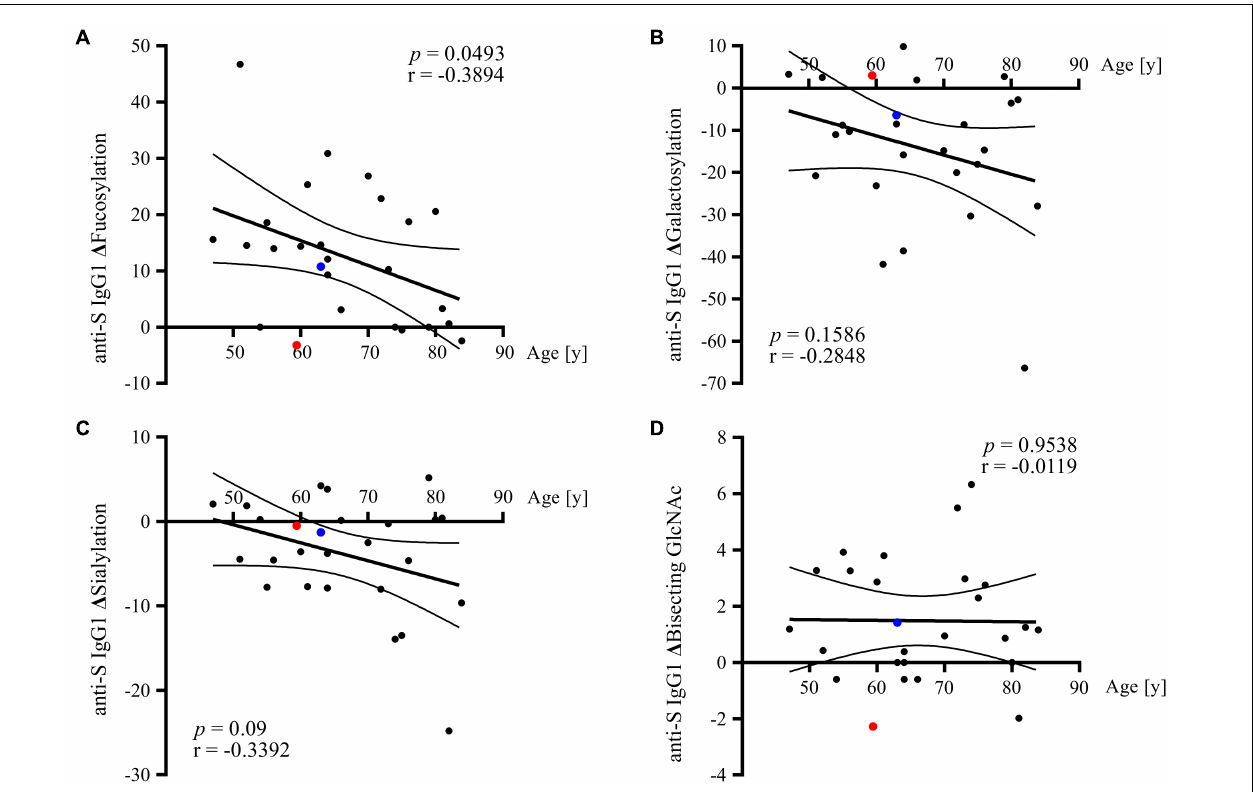
FIGURE 5 | Correlation of anti-S IgG 1 glycosylation alterations with patients’ age. In each graph, the Y axis represents the difference ( (cid:49) ) in the relative abundance of the respective glycosylation trait recorded between the last and first hospitalization time-point: (A) (cid:49) fucosylation, (B) (cid:49) galactosylation, (C) (cid:49) sialylation, and (D) (cid:49) bisecting GlcNAc. Data points corresponding to the two deceased COVID-19 patients are indicated in red (patient 1) and blue (patient